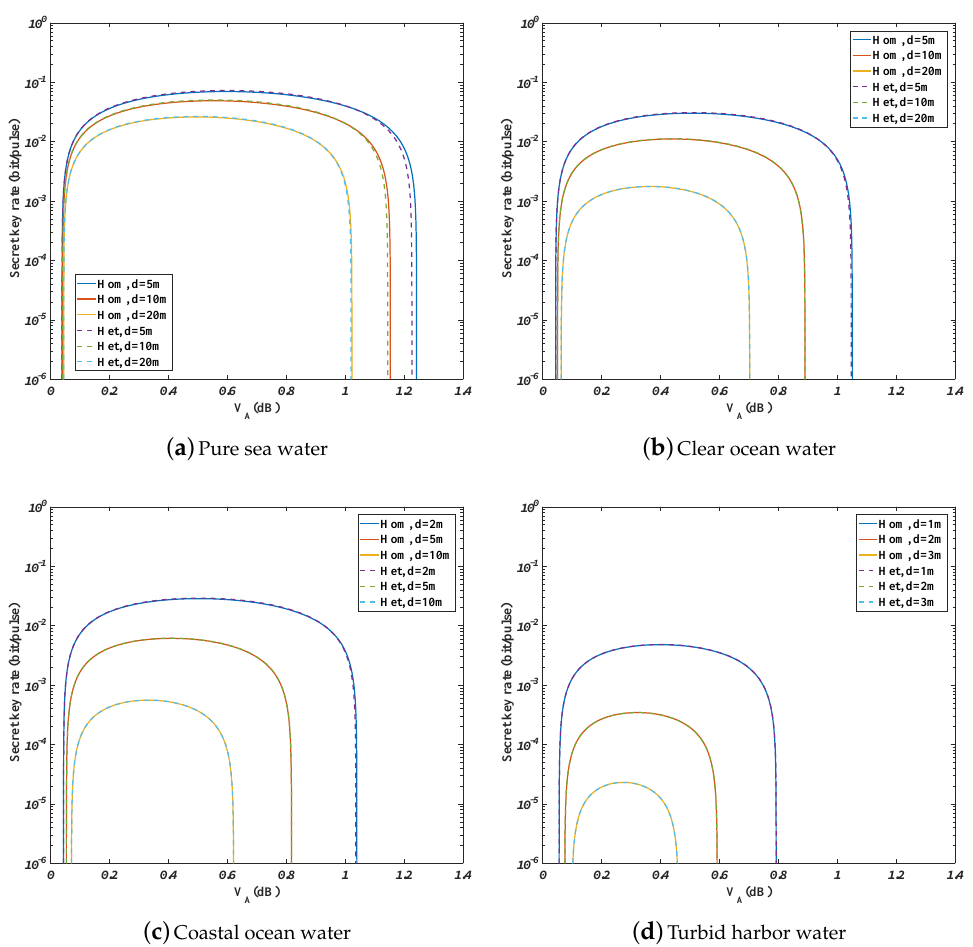
Figure 9. (Color online.) The compressed variation trend of V A optimal interval of the four-state protocol as the transmission distance extends. β = 0.9, ε = 0.005, η = 0.6, v el =